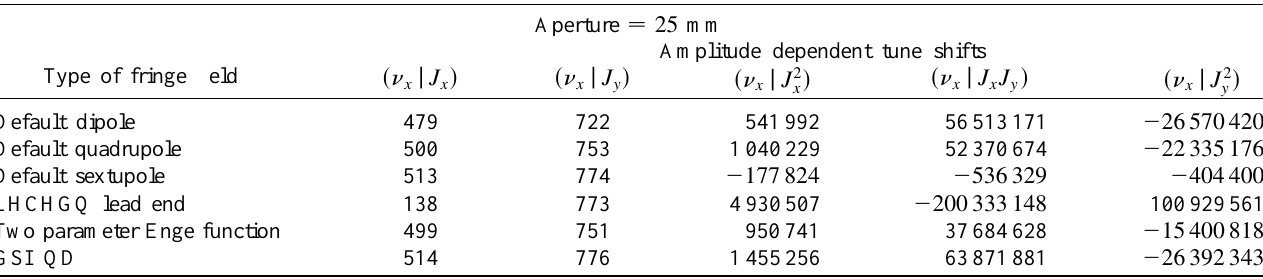
TABLE IV. A few amplitude dependent tune shifts for the 25 mm aperture case. All six of the studied fringe field fall-off shapes are included.